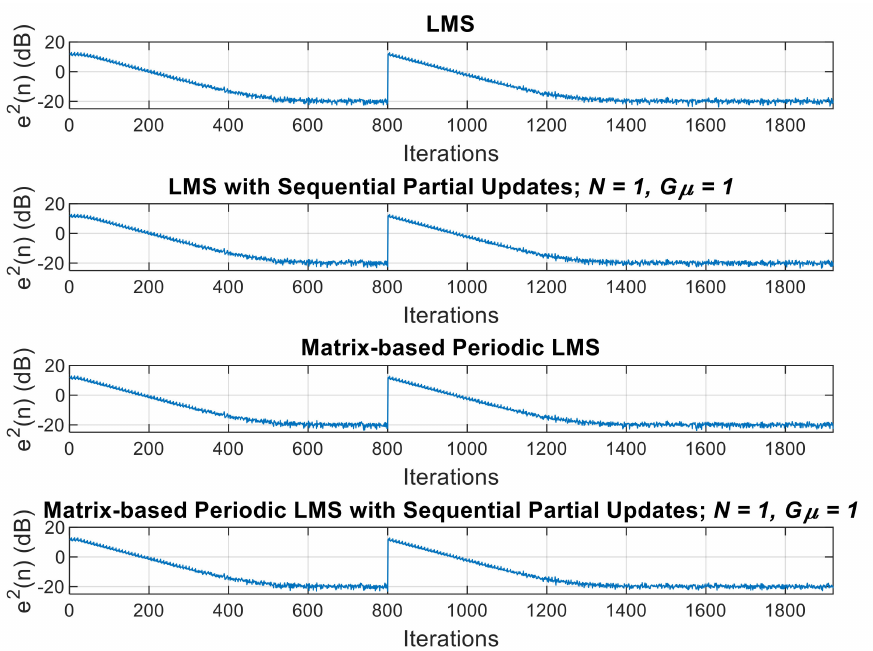
Figure 9. Learning curves comparison. Version 1 of the experiment: desired signal d 1 ( n ) and reference signal x 1 ( n ) . ( a ) LMS, ( b ) LMS with Seq PU; N = 1 and G µ = 1, ( c ) P-LMS, ( d ) P-LMS with Seq. PU; N = 1 and G µ = 1. Average of 50 runs. The performance measure used is the instantaneous squared error in logarithmic scale